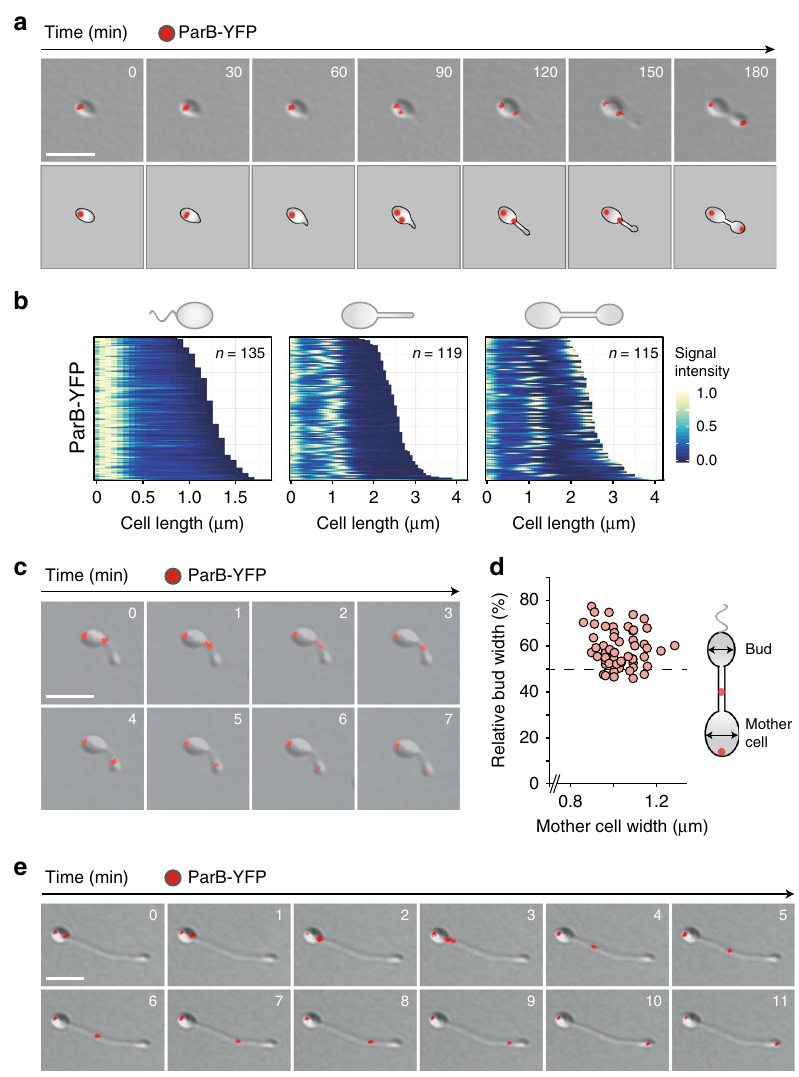
Fig. 2 Two-step segregation of the sister ori regions. a Time-lapse series showing the localization of ParB-YFP over the course of the cell cycle. H. neptunium KH22 ( parB-yfp ) was grown in MB medium, transferred to an MB-agarose pad, and imaged at 30 min intervals. Shown are overlays of differential interference contrast (DIC) and fl uorescence micrographs as well as schematics of the fl uorescence patterns observed. Bar: 3 µ m. b Demographic analysis of ParB-YFP localization in swarmer (left), stalked (middle), and budding (right) cells of strain KH22. The fl uorescence intensity pro fi les obtained for each cell type were sorted according to cell length and stacked on each other, with the shortest cell shown at the top and the longest cell shown at the bottom. Note that due to the variable length of the stalk, the total cell length only roughly corresponds to the developmental state of the cell. c Time-lapse series showing the movement of ParB-YFP through the stalk of strain KH22. Cells were imaged at 1 min intervals. Shown are overlays of DIC and fl uorescence images. Bar: 3 µ m. d Relative size of the bud at the onset of the second segregation step. Strain KH22 was imaged at 5 min intervals. At the fi rst time point at which ParB-YFP had left the stalk base to migrate toward the bud, the widths of the mother cell and bud compartments were measured. The graphs show the relative width of the bud plotted versus the absolute width of the mother cell ( n = 57). The average of the data is 60 ± 7%, corresponding to a total width of 0.61 ± 0.08 µ m. e Time-lapse series following ori translocation through the elongated stalk of a phosphate-starved cell. Strain KH22 was grown in minimal medium lacking phosphate for 22 h. Subsequently, MB medium was added to a fi nal concentration of 20% and growth was continued for 40 min. After transfer of the cells onto an MB-agarose pad, images were taken at 1 min intervals. Shown are overlays of DIC and fl uorescence